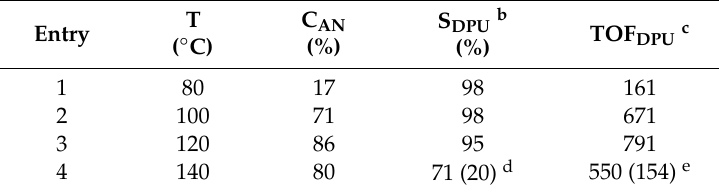
Parameters obtained for the carbonylation of aniline by CO / CO 2 / O 2 catalyzed by PdCl 2 (2,4-Cl 2 Py) 2 : conversion (C AN ), selectivity (S DPU ) and turnover frequency (TOF DPU ), depending on the temperature a